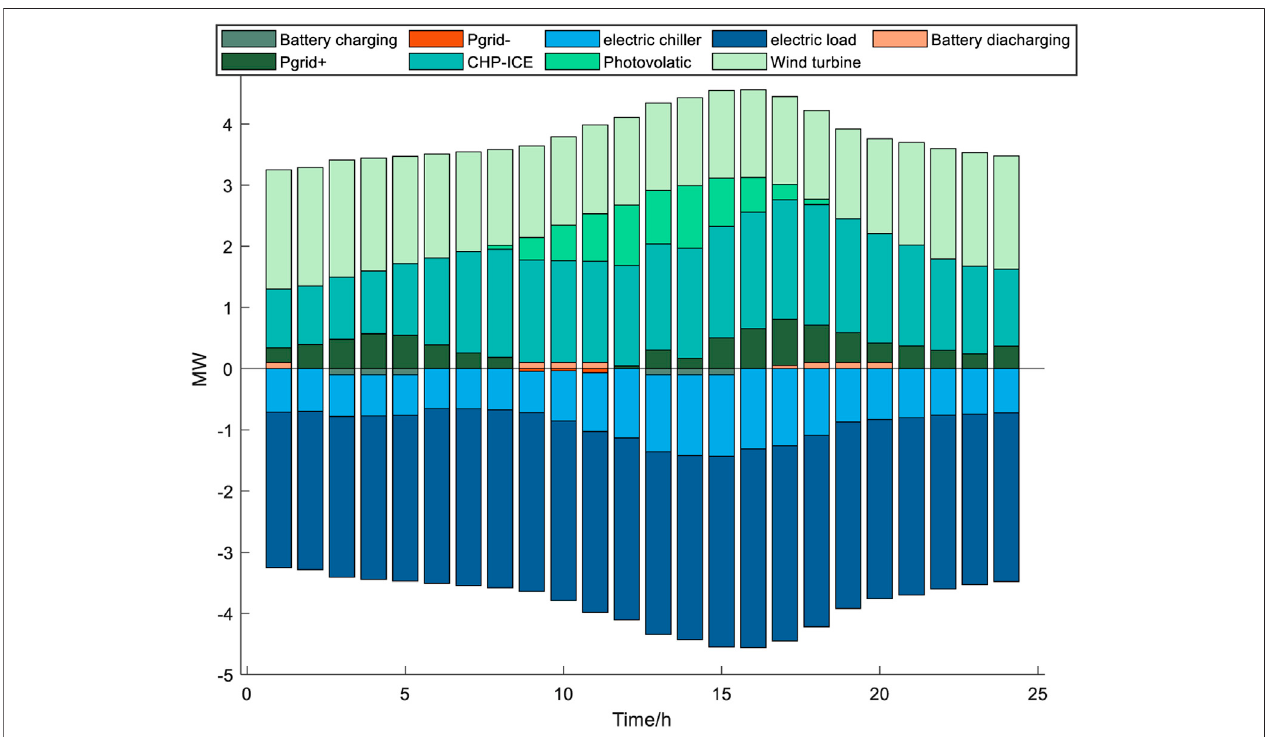
FIGURE 7 | Diagram of optimized dispatching results of electric